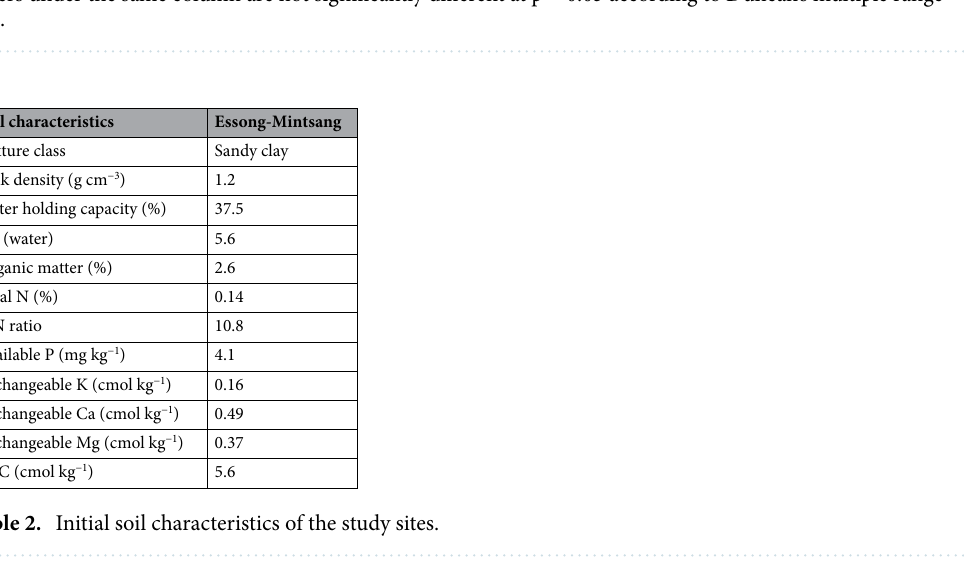
Table 2. The soil profile described in the site belongs to ferralsols group according to WRB 19 , with sandy clay tex-